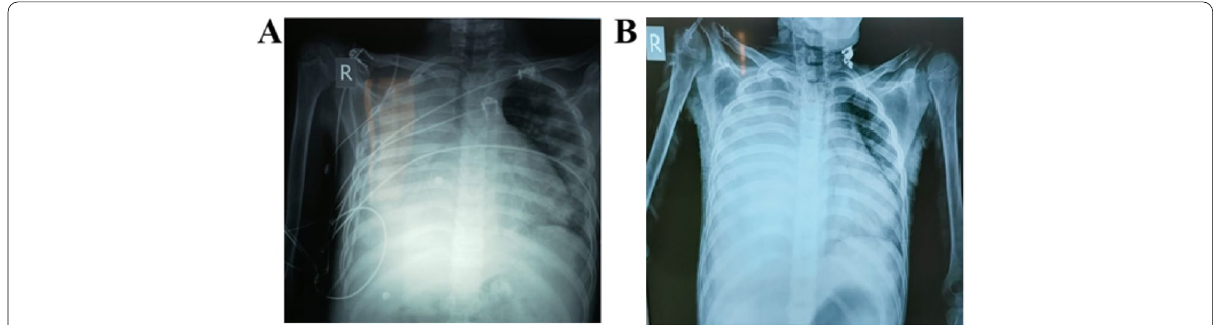
Fig. 1 Chest X‑ray of the patient showing massive right side pleural effusion. A Pleural effusion after the third day of pleurocentesis on the first presentation. B Reappearance of pleural effusion 4 weeks after first